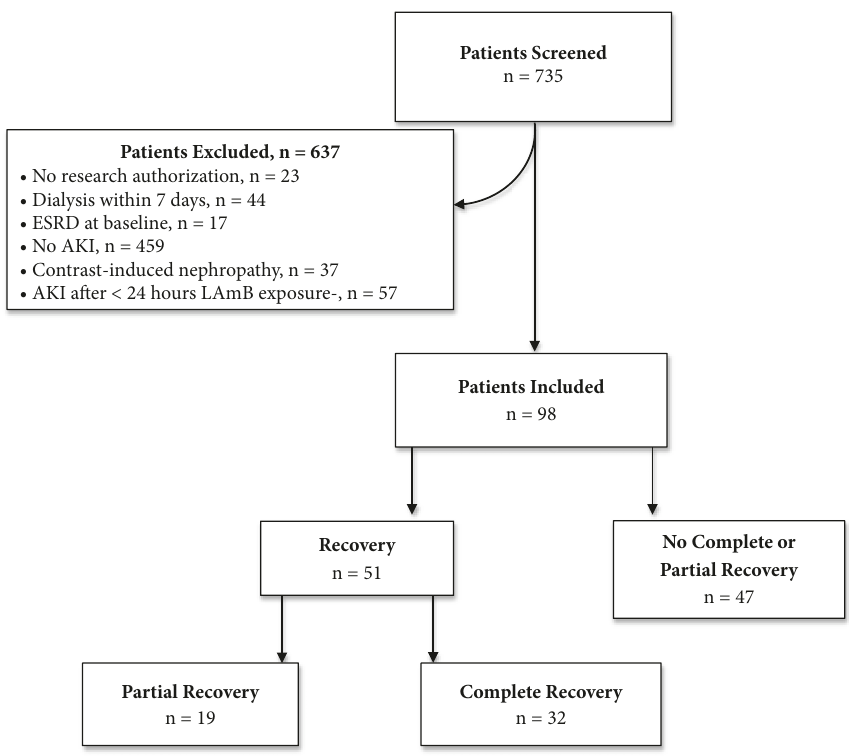
Figure 1: Consort diagram: 735 patients who received LAmB at Mayo Clinic between 2008 and 2015 were screened. 637 were excluded, leaving 98 patients available for